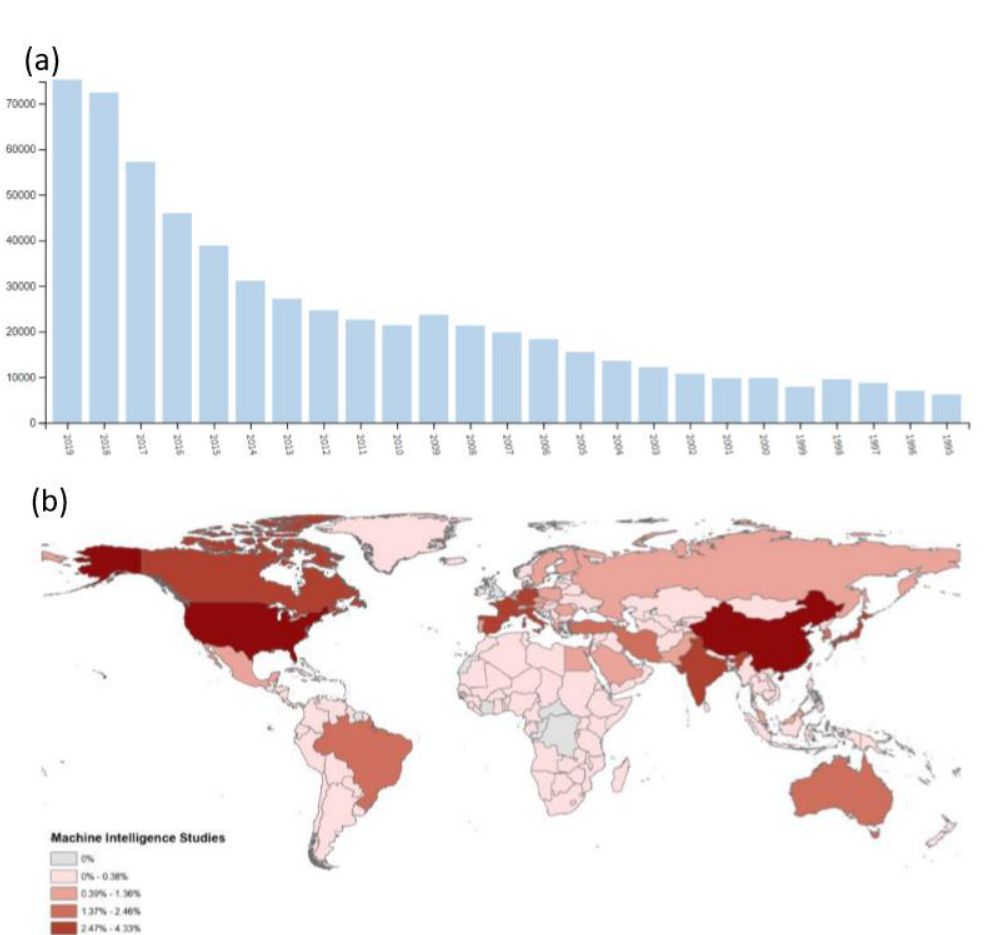
Figure 3. Quantity and geographic distribution of MI research (n = 621,630). ( a ) Graph of the total number of publications on MI work in all disciplines since the 1990s included in the Web of Science database. ( b ) Geographic distribution of MI studies in panel (a), indicating a concentration of development in North America, China, and parts of Europe (primarily in the West). South America and Africa contain the lowest percentage of MI research output. This result concurs with Microsoft Academic search queries.